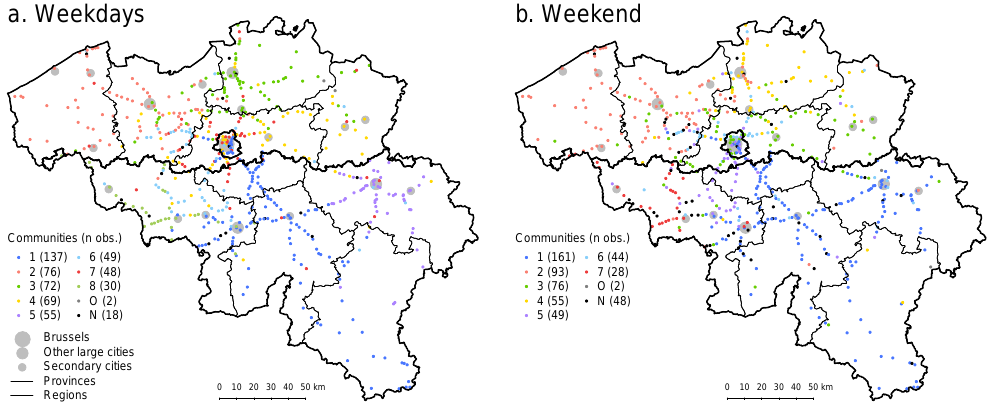
Figure 6. Communities detected in the iRail dataset during ( a ) weekdays and ( b ) weekends (in the legend: O = other communities, with less than five nodes; N = not present in the